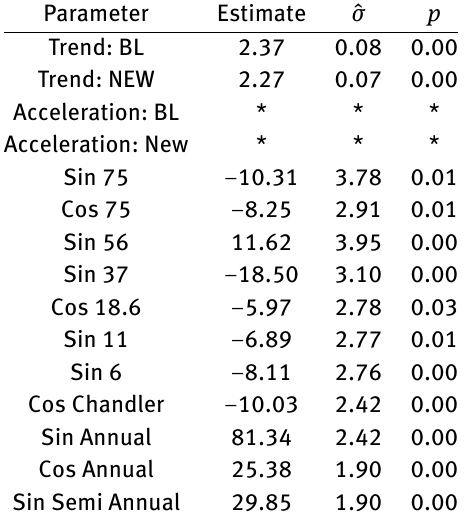
Table 3: Key West USA solutions as an example. Statistically sig- nificant estimates are in mm except trend (mm/yr). BL: baseline kinematic model solution. NEW: extended kinematic model solution with periodicites and autocorrelated disturbances.